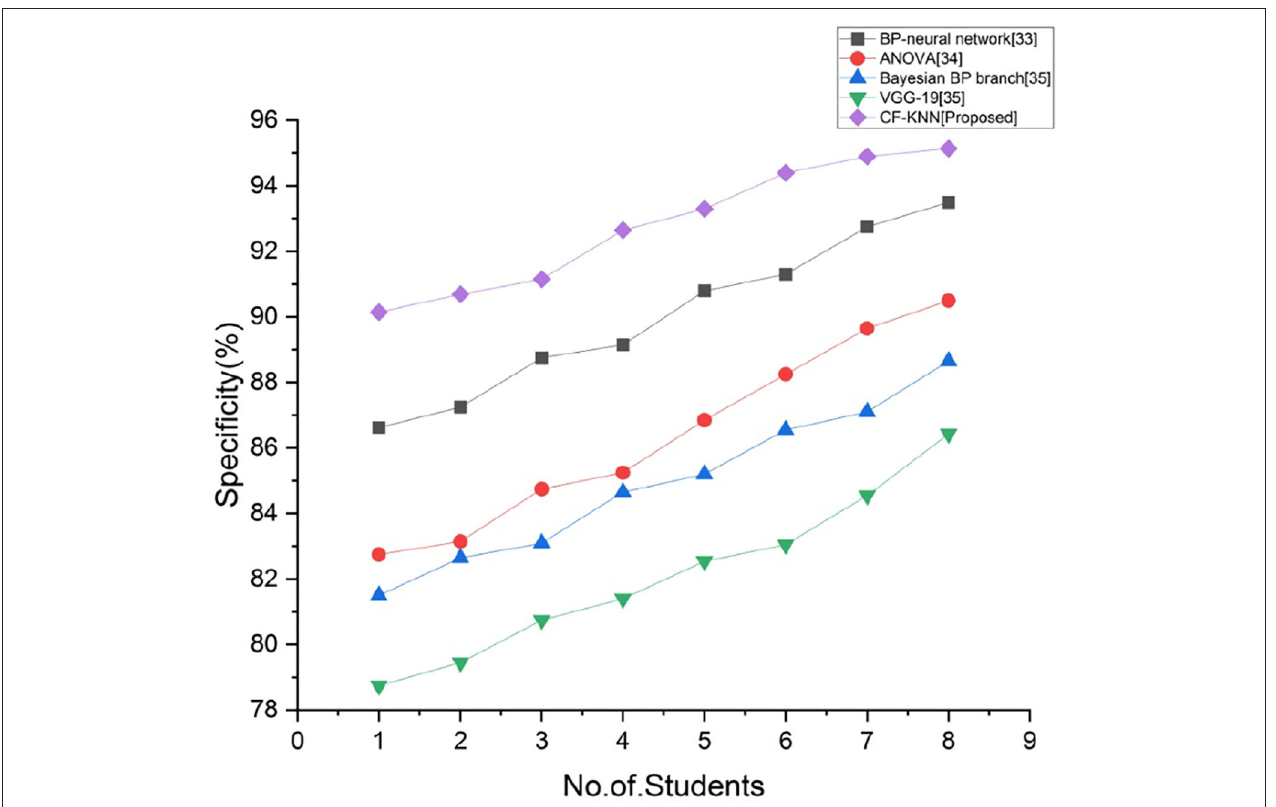
FIGURE 8 | Comparison of specificity with proposed and existing